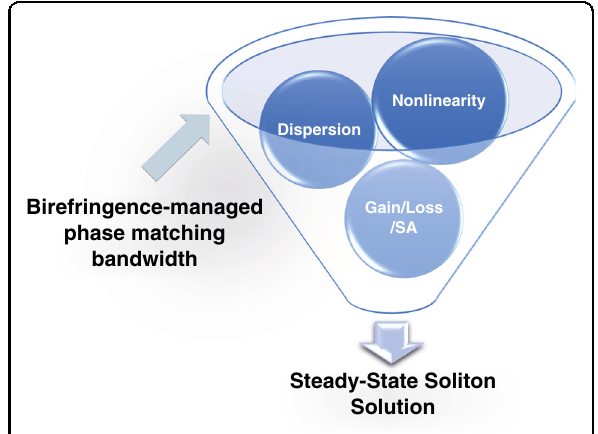
Fig. 1 Principle of BMS Illustration of the key elements involved in birefringence-managed soliton